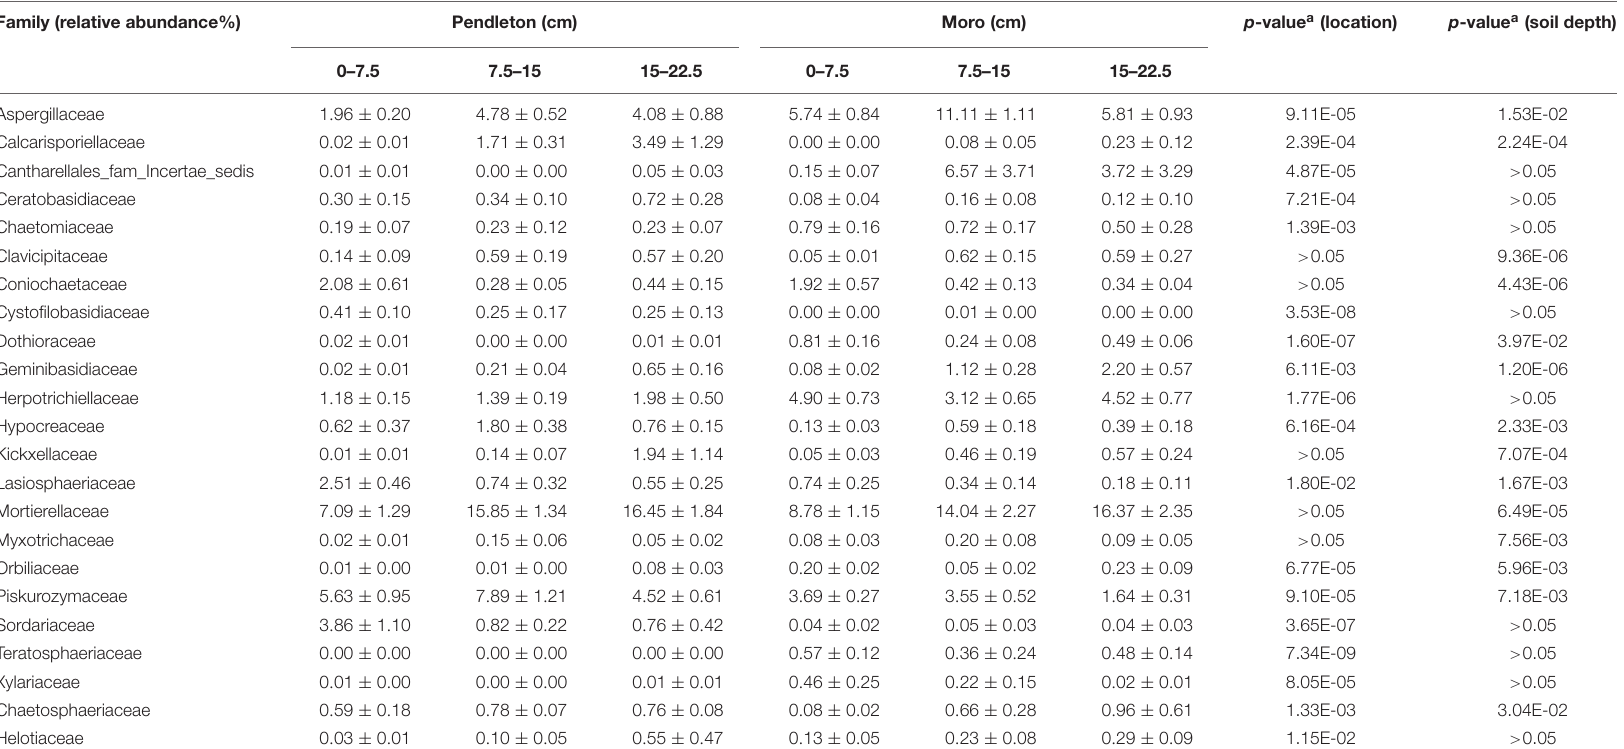
TABLE 1 | The relative abundance ( ± standard error) of fungal families significantly impacted by location and soil depth without liming. Family (relative